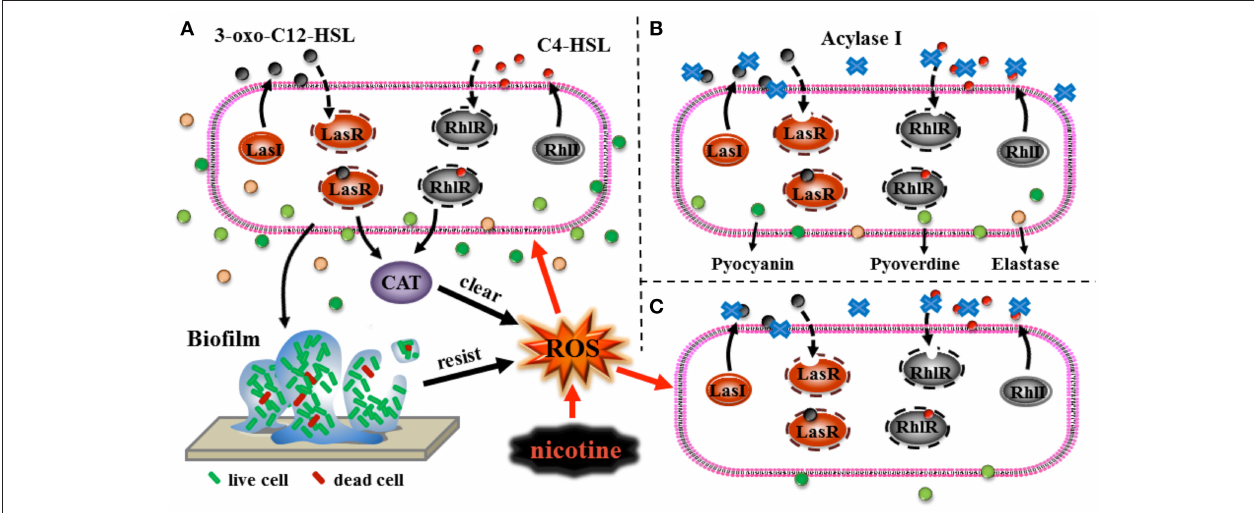
FIGURE 8 | Schematic representations of the role of QS in nicotine tolerance (A) , QQ leading to reduction of virulence (B) , and the high efficiency of QQ under nicotine exposure leading to reduction of virulence (C) . Black arrows represent the direction of signals transduction or direction of transport of the virulence factors, black dotted arrows represent the process of the binding of ligands to the respective receptors, black thick arrows represent clearing of ROS or resistance to stress, and red arrows represent induction of ROS production or induction of stress to